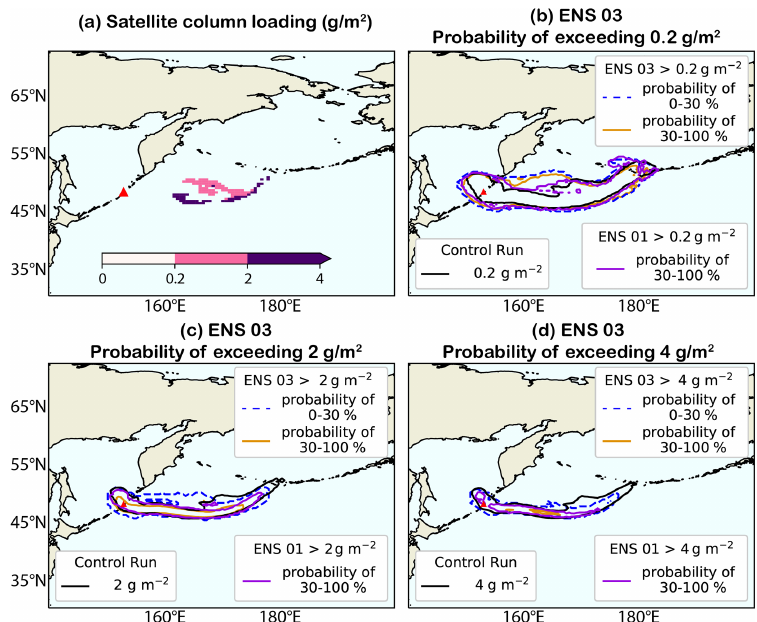
Figure C1. Same probability maps as in Fig. 7 in the main paper, with the addition of the 0%–30% probability region for ENS03 to exceed mass loading of (b) 0.2gm − 2 , (c) 2gm − 2 , and (d) 4gm − 2 (dashed blue contours; the region within the blue line is a probability region up to